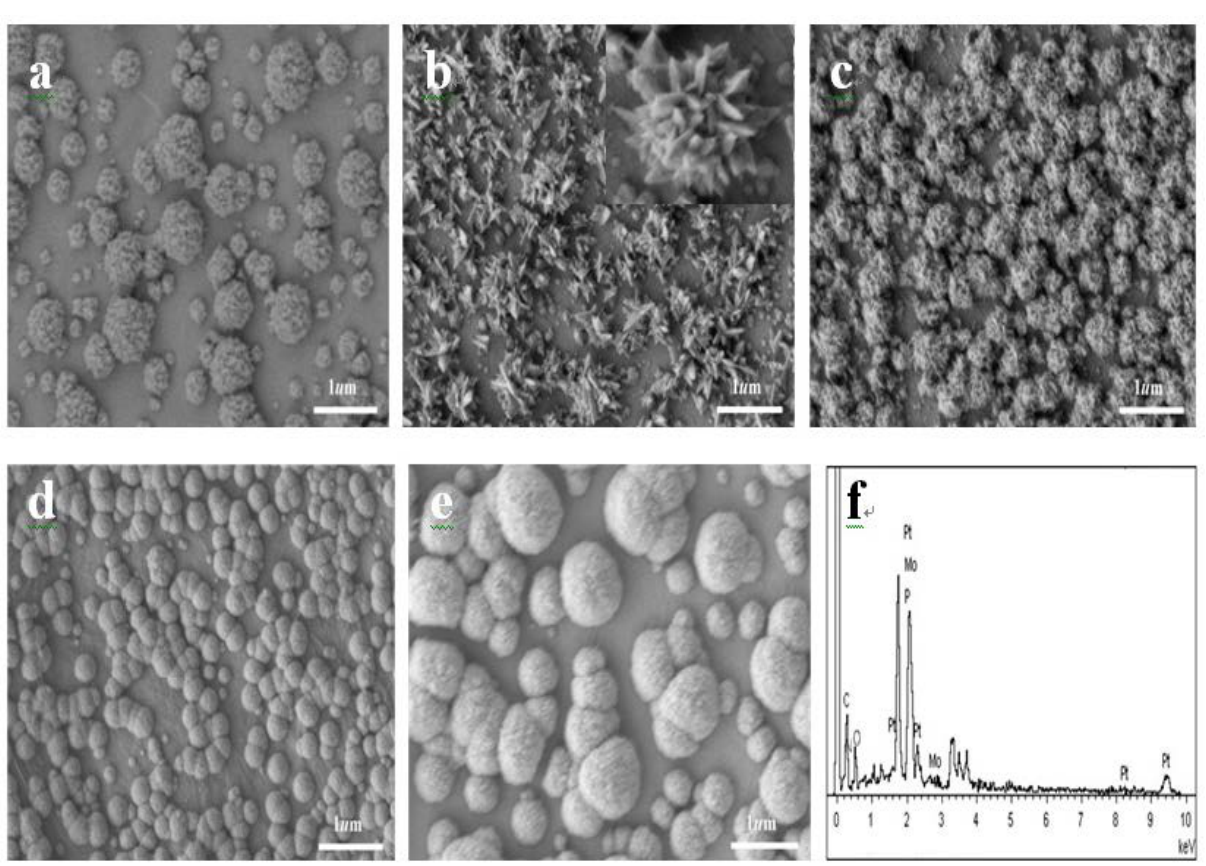
Figure 5. SEM images of different modified electrodes: ( a ) PMo 12 -Pt/rGO/ITO composites at − 0.2V; ( b ) PMo 12 -Pt/rGO/ITO composites at − 0.3V; ( c ) PMo 12 -Pt/rGO/ITO composites at − 0.4V; ( d ) Pt/rGO/ITO composites at −0.3V; ( e ) PMo 12 -Pt/ITO composites at −